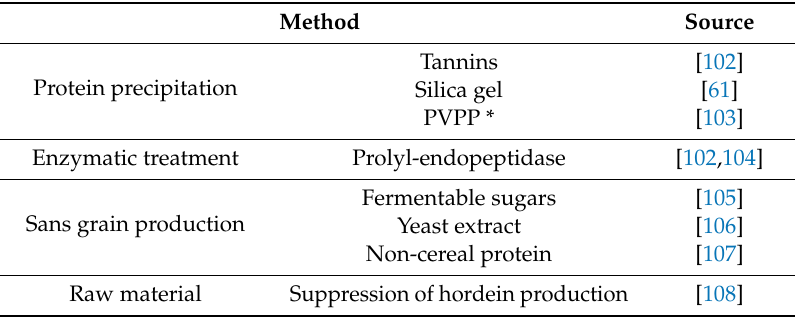
Table 1. Other methods for production of gluten-free